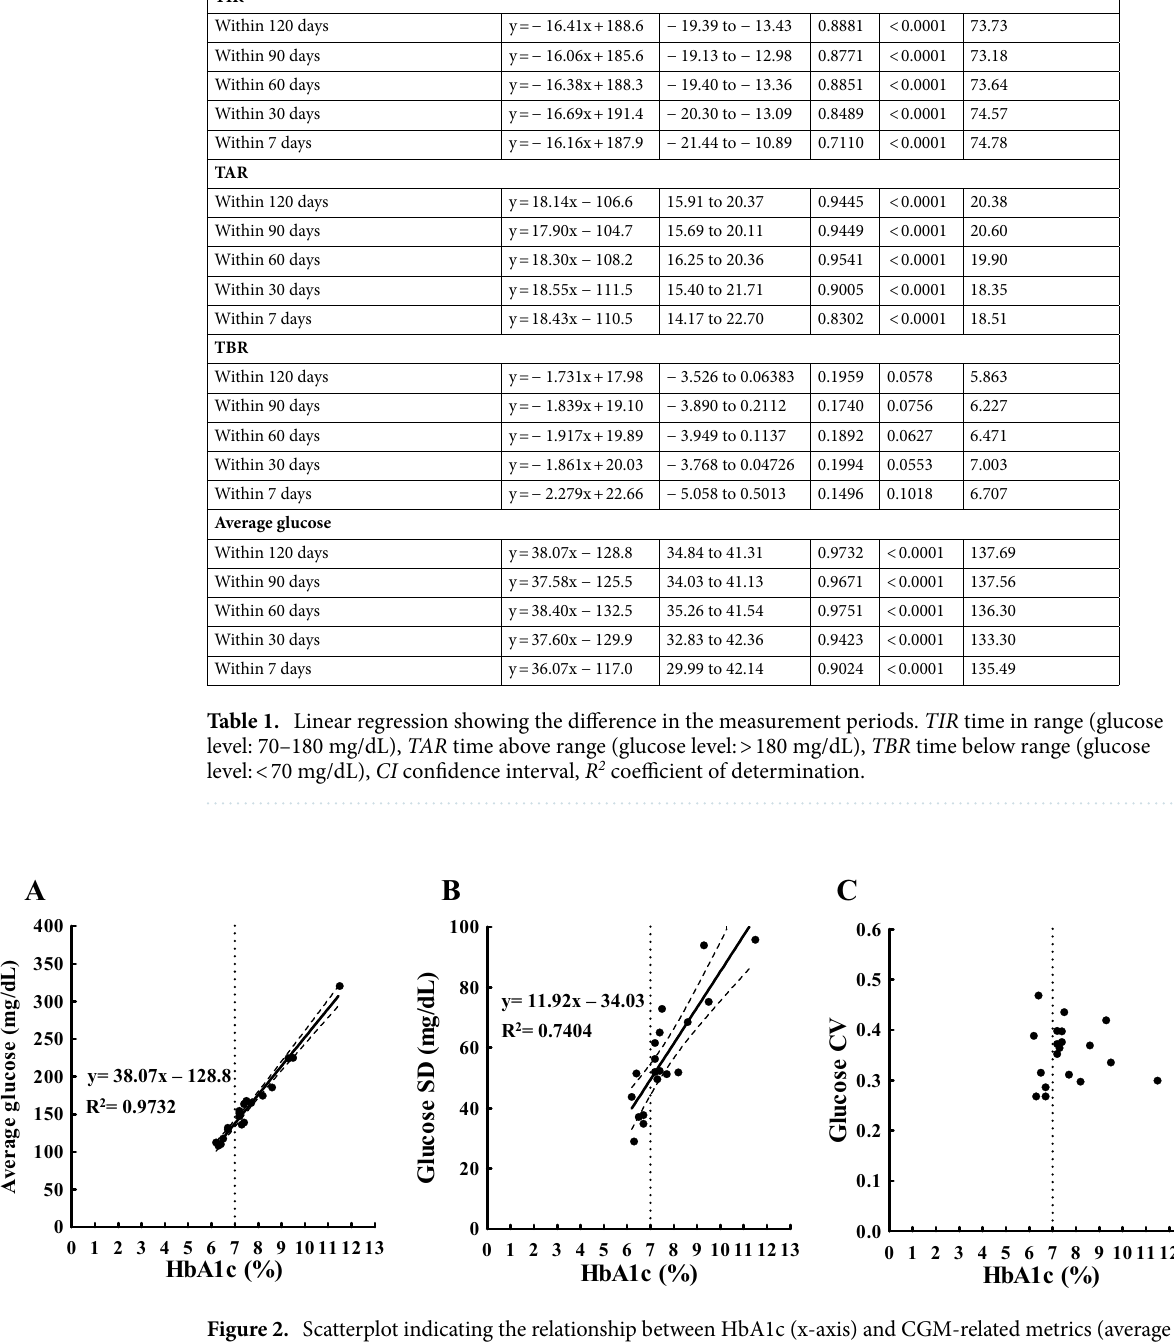
Figure 2. Scatterplot indicating the relationship between HbA1c (x-axis) and CGM-related metrics (average glucose ( A ), glucose SD ( B ), and glucose CV ( C ); y-axis) measured within 120 days from baseline. The solid line is the line of best-fit from the linear regression analysis. The dashed band is the 95% confidence band of the best- fit line. The dotted vertical lines represent an HbA1c of 7%. SD standard deviation, CV coefficient of variation, R 2 coefficient of